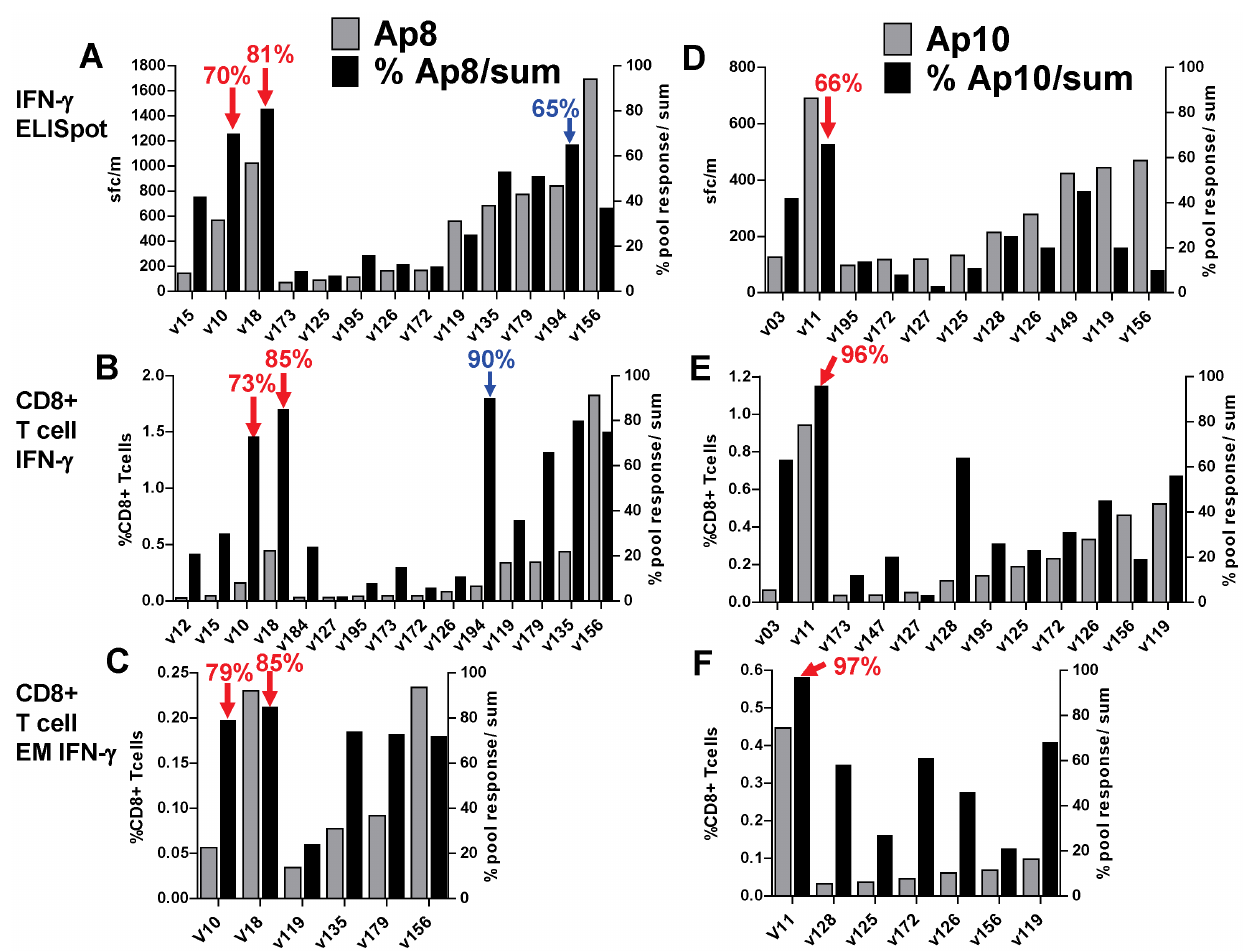
Figure 8. DNA/Ad and AdCA: Comparison of positive T cell activities and per cent of total activities to AMA1 peptide pools. ELISpot IFN- c , CD8 + T cell IFN- c , and CD8 + T cell EM IFN- c activities to individual AMA1 peptide pools (Ap8 and Ap10) were calculated as per cent of total activities of summed responses to all AMA1 peptide pools. All volunteers positive with Ap8 or Ap10 were selected. Panels A, B, C: Ap8: protected v10 and v18 had lower activities than one or more AdCA volunteers, but highest per cent activities; v194 (delay to patency, blue arrows) had higher per cent ELISpot and CD8 + T cell IFN- c activities than other AdCA volunteers, but no CD8 + T cell IFN- c EM activity. Panels D, E, F: Ap10: protected v11 had highest per cent ELISpot, CD8 + T cell IFN- c and CD8 + T cell IFN- c EM activities to